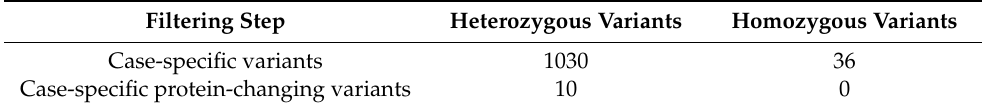
Table 2. Shared variants in the two sequenced cases.